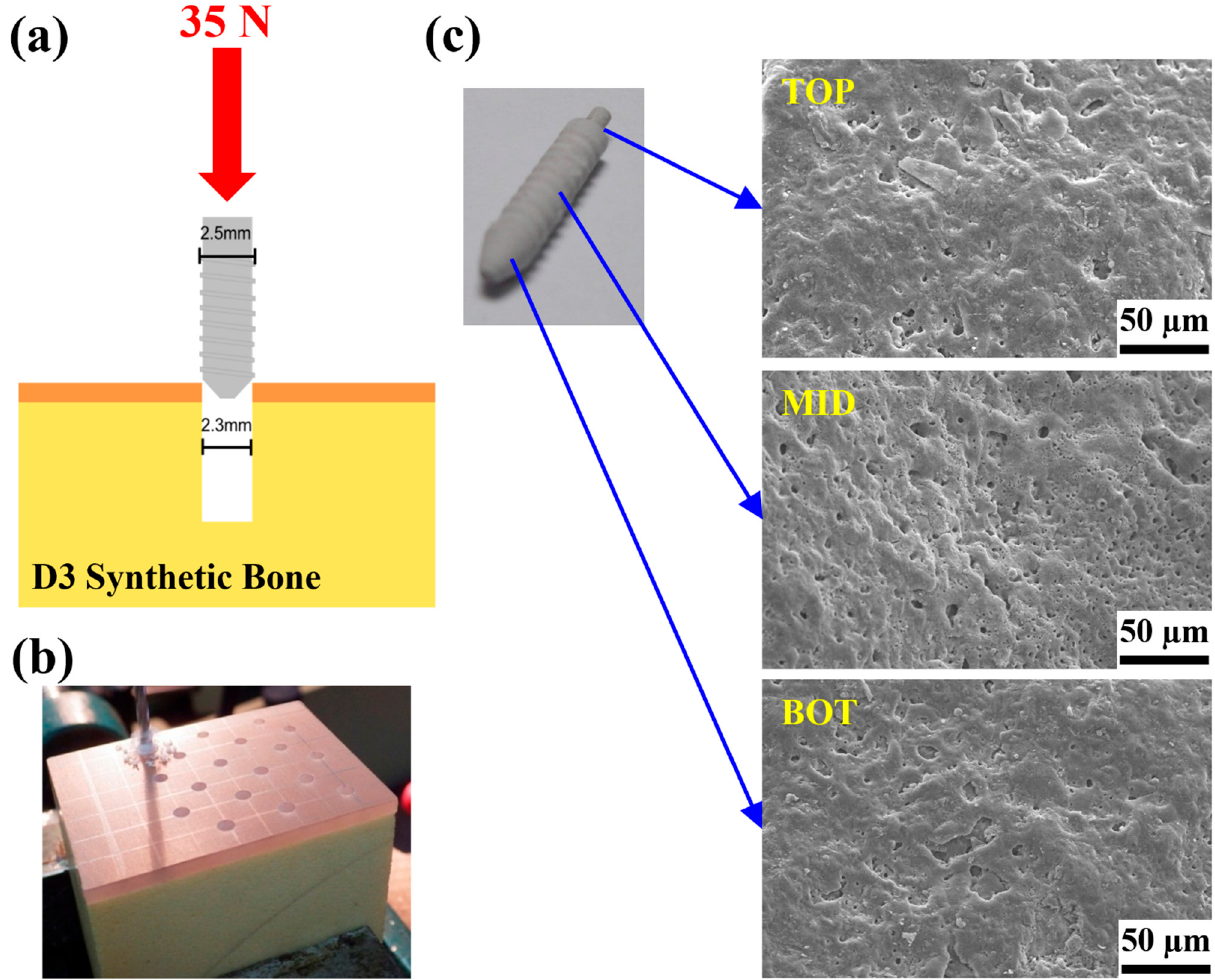
Figure 9. ( a , b ) Test setup for the locking force and ( c ) SEM morphology of the ZK60 Mg alloy bone screws treated with MAOCa after the locking force testing. Table 4. Locking force of the ZK60 Mg alloy bone